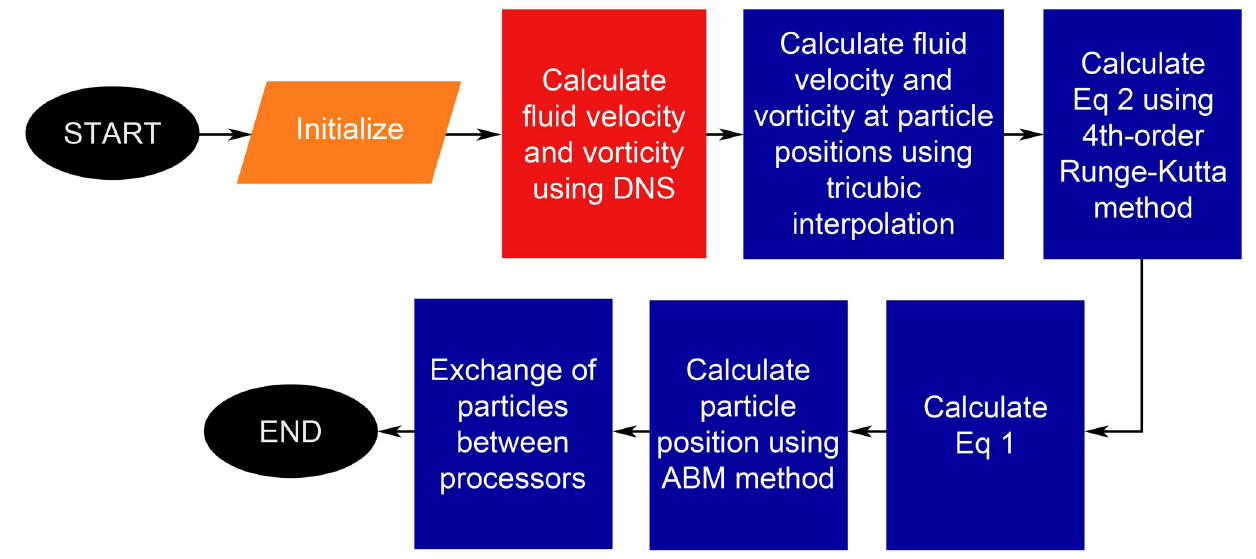
Fig 1. Numerical simulation workflow. The red box corresponds to the fluid calculation while the blue boxes correspond to the particle calculations.